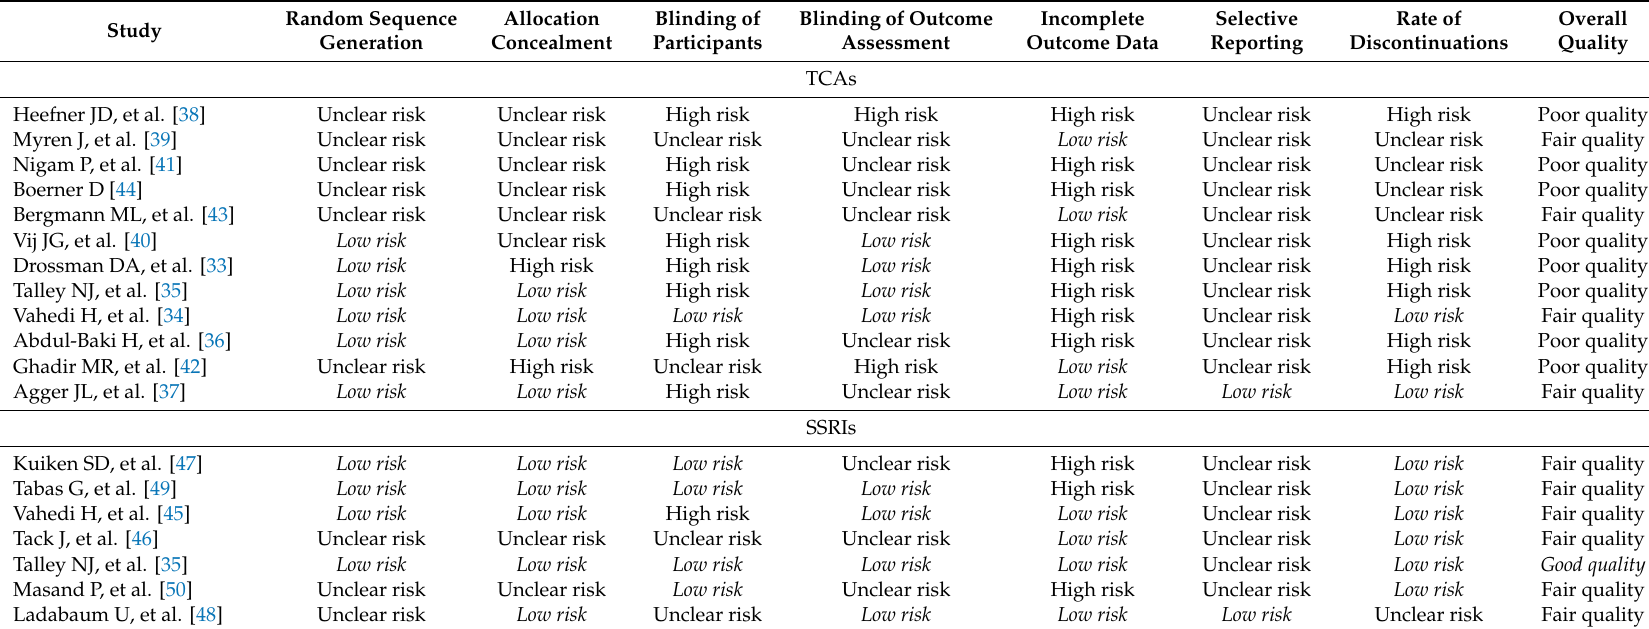
Table 2. Summary of bias risk in clinical studies of antidepressants in irritable bowel